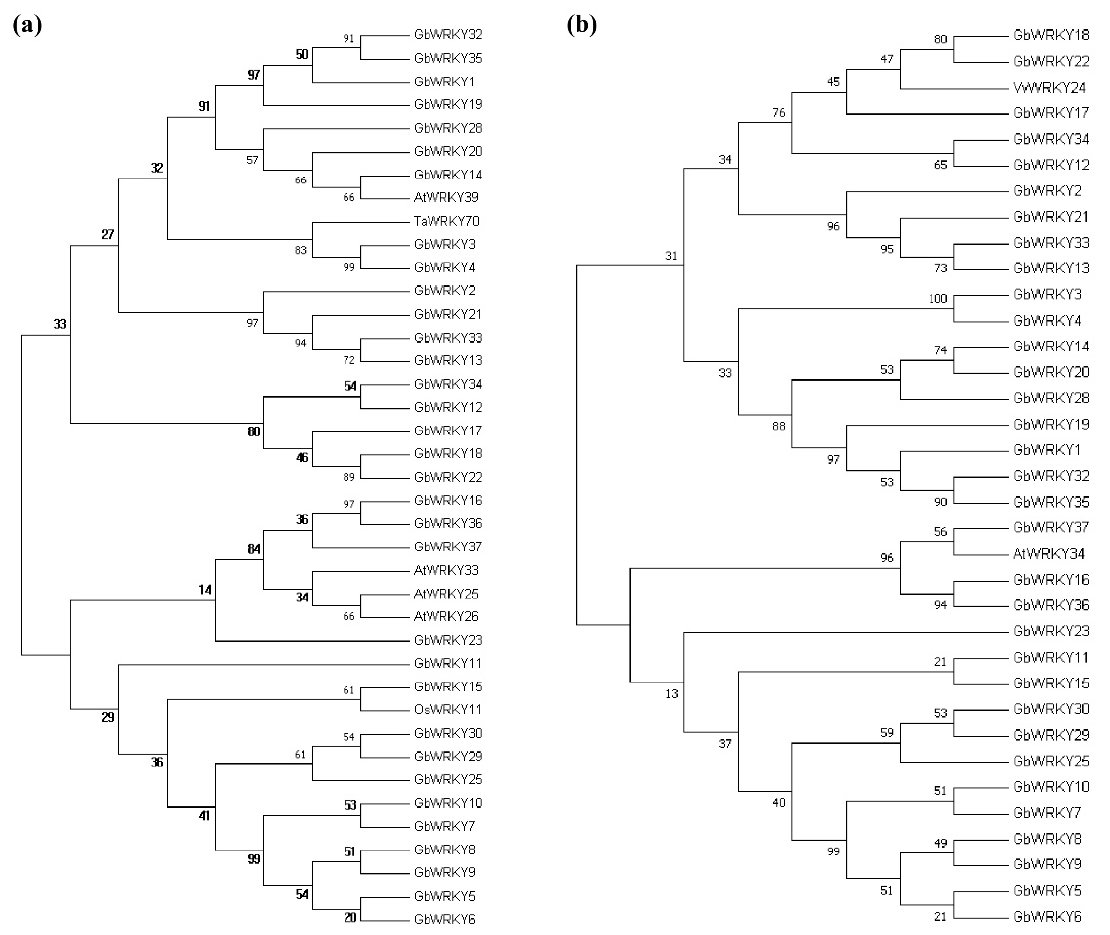
Figure 8. Phylogenetic tree of GbWRKYs and known WRKYs associated with high temperature stress ( a ) and low temperature stress ( b ).